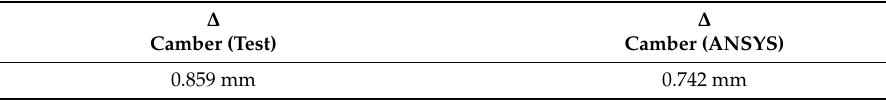
Table 3. Values comparison of ∆ camber.